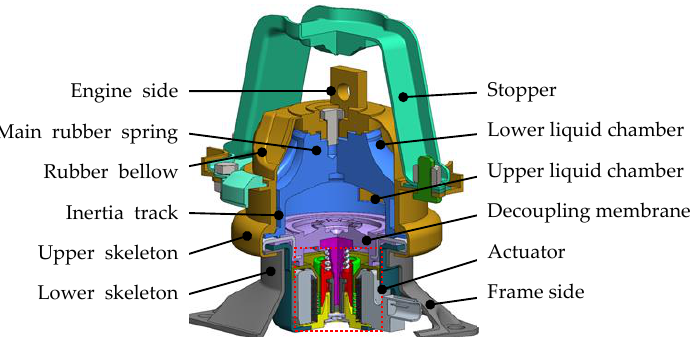
Figure 2. 3-D model for active hydraulic mount with solenoid actuator (AHM-SNA).